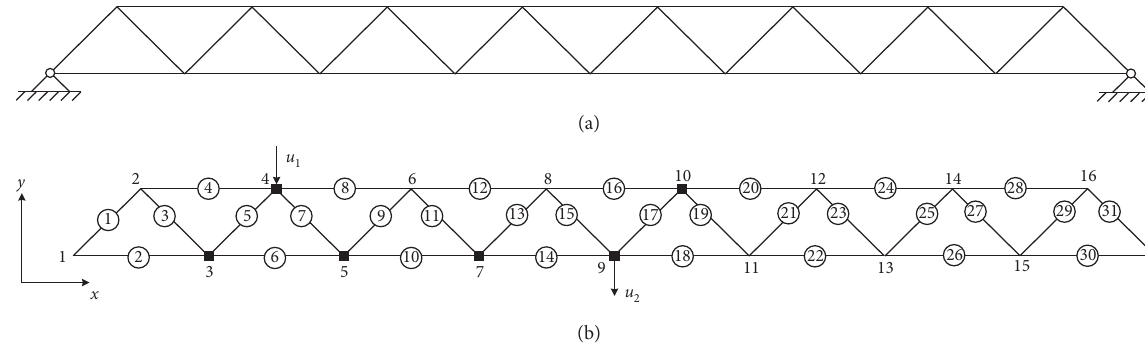
Figure 1: (a) Structure of plane girder. (b) FE model on sensor and truss configuration.